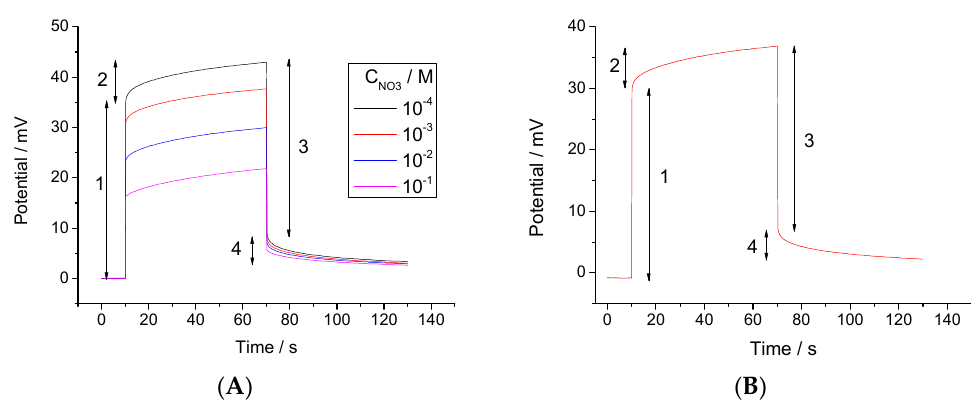
Figure 2. ( A ) Chronopotentiometric curves obtained with ISE 1 after five days soaking in the respective solutions; 1: positive Ohmic drop, 2: polarization, 3: negative Ohmic drop, 4: relaxation—all for 10 − 4 KNO 3 ; ( B ) The dependence of the Ohmic drop value in 0.001 M KNO 3 on the soaking time.